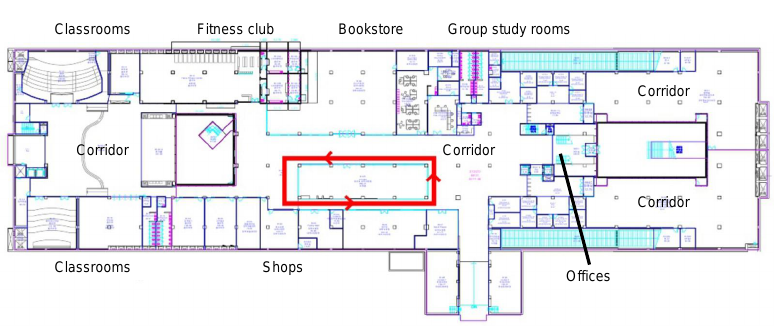
Figure 3. Trace generation environment in Korea University: Engineering College Building ( top ), Convergence Technology Hall ( middle ), and Campus Square ( bottom